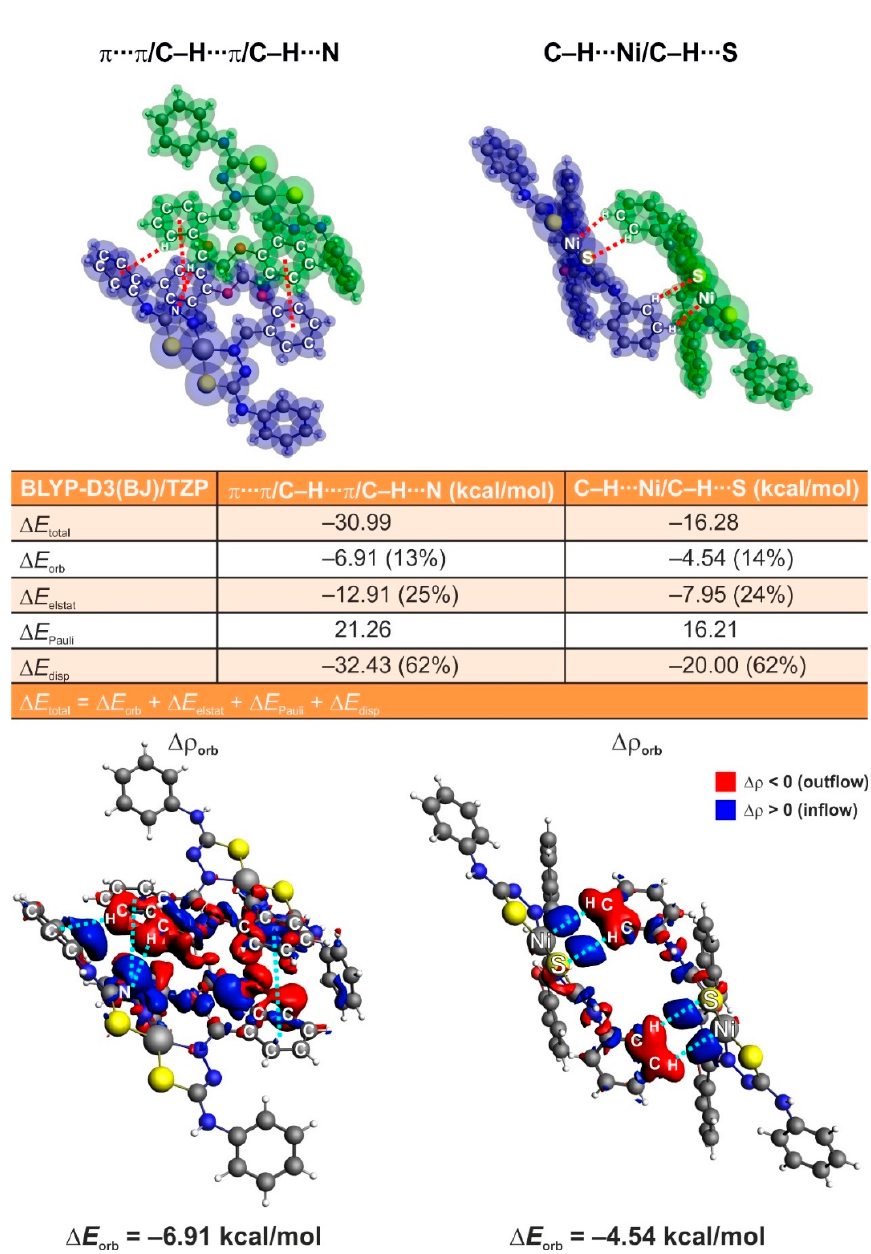
Figure 7. The results of ETS-NOCV energy decomposition describing π ∙∙∙ π , C–H ∙∙∙ π and C–H ∙∙∙ N (left), and C–H ∙∙∙ Ni and C–H ∙∙∙ S (right) interactions in 1 . Additionally, the overall deformation density Δρ orb with the corresponding Δ E orb are presented.